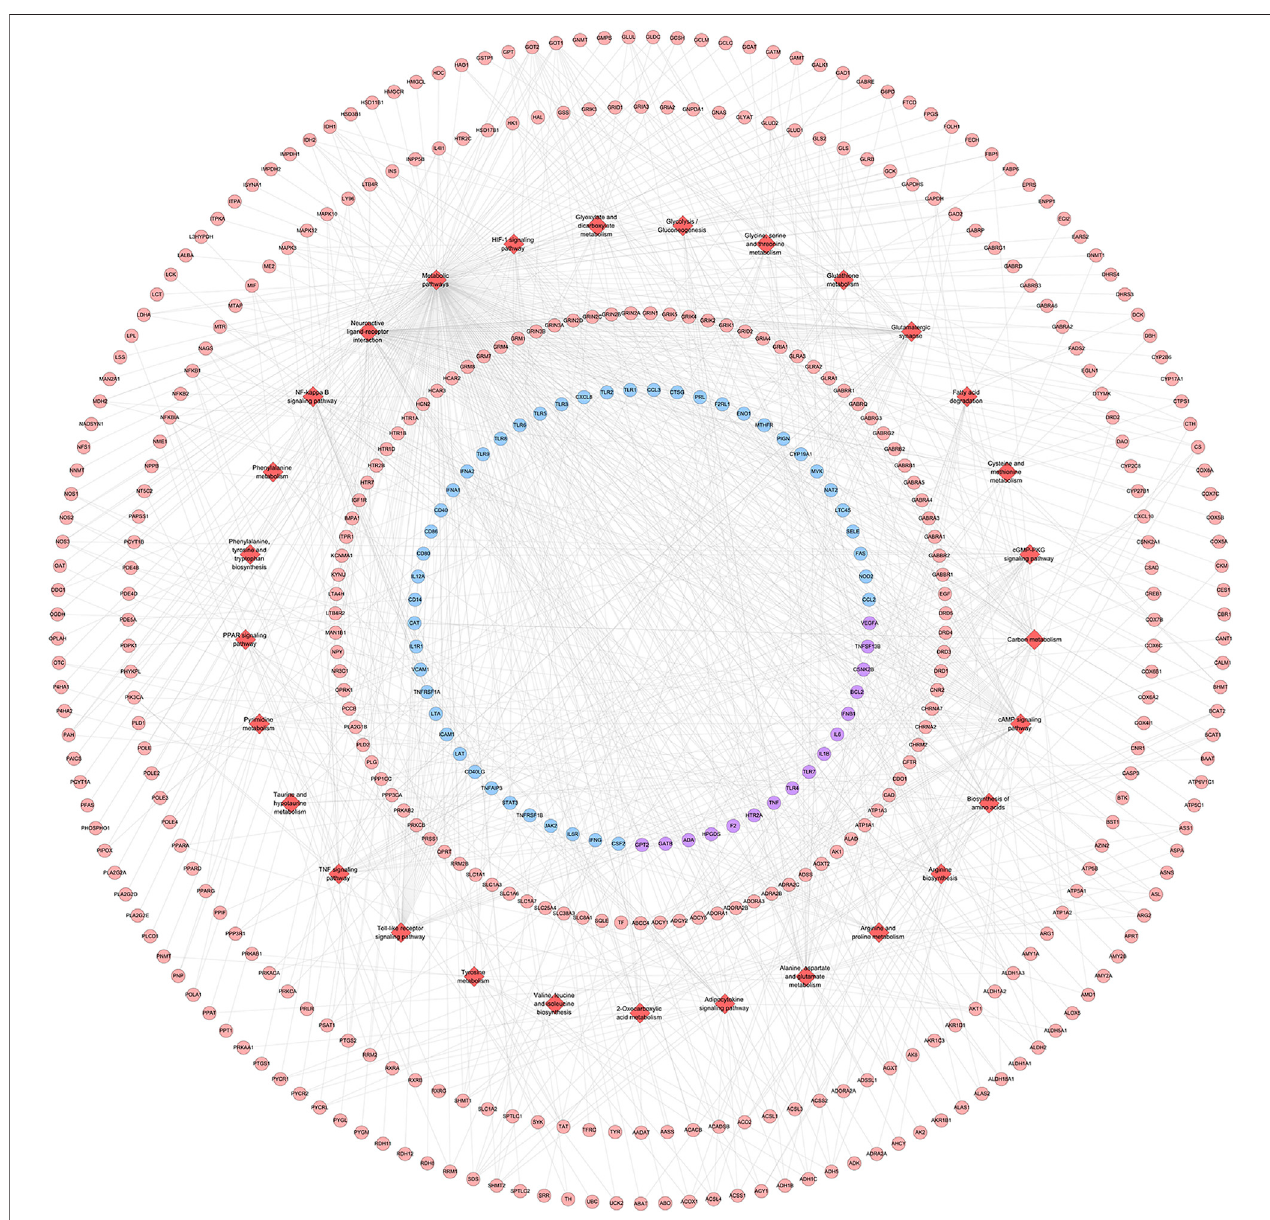
FIGURE 7 | ZBDHD-orchitis PPI Network (Red diamond stand for signaling pathway. Pink circles stand for ZBDHD target, Blue circles stand for orchitis targets, purple circles stand for ZBDHD-orchitis target).